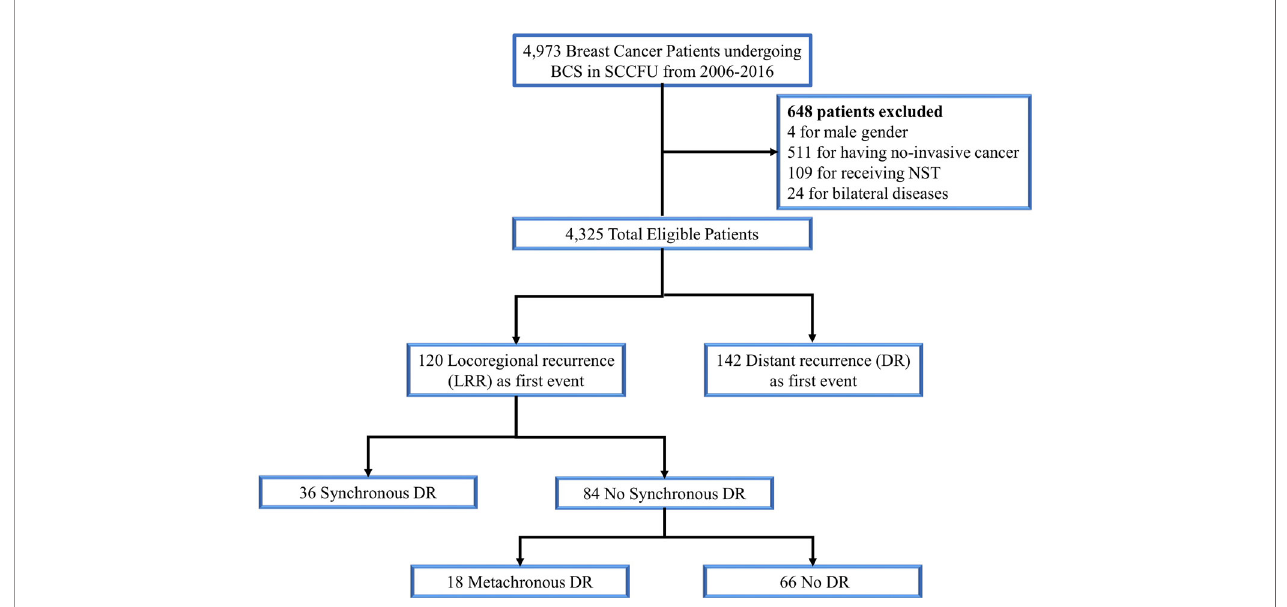
FIGURE 1 | Consort diagram for the study cohort. SCCFU, Shanghai cancer center of Fudan university; BCS, breast-conserving surgery; NST, neoadjuvant systemic therapy; DR, distant